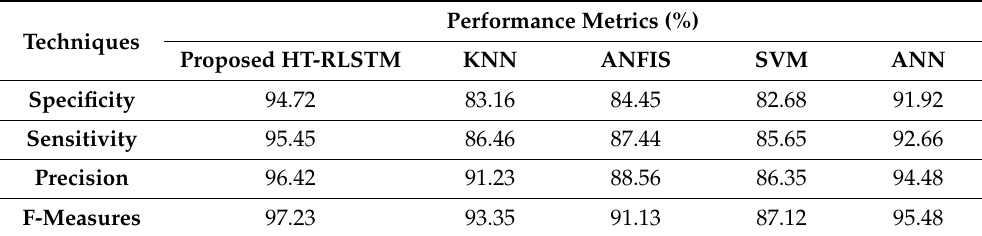
Table 2. Performance analysis of the proposed HT-RLSTM based on specificity, sensitivity, precision, and recall.